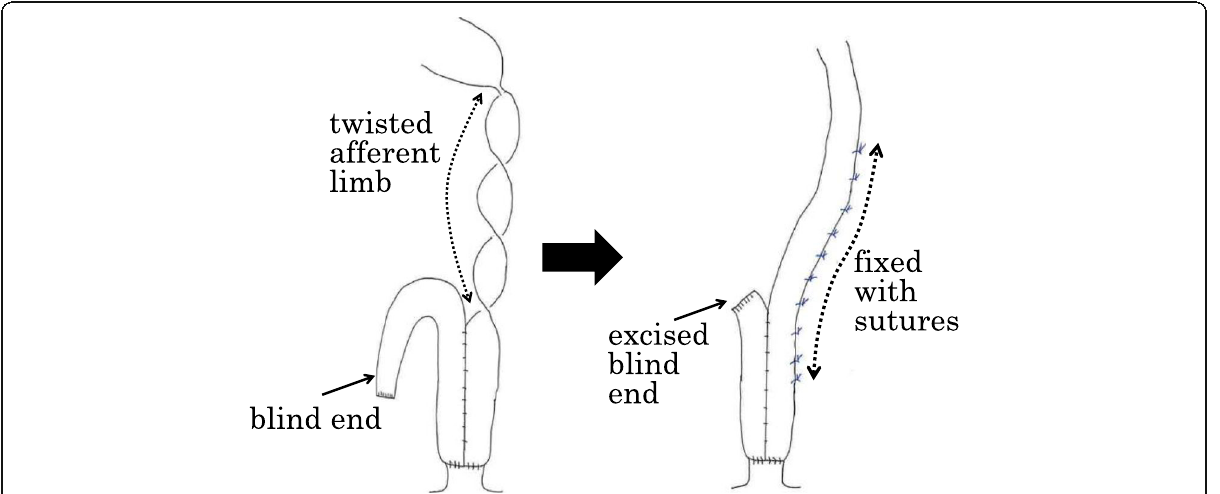
Fig. 7 The blind end of the ileum was adhering to the pelvic floor. The remaining blind end of the ileum was excised. Since the ileal pouch and the afferent limb were easily twisted, we fixed them to the retroperitoneum with sutures